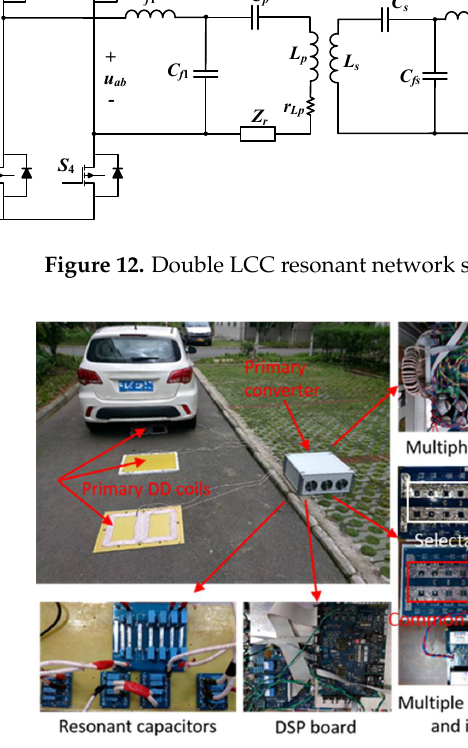
Figure 13. Photograph of the test prototype. Table 2. Specifications of the prototype.